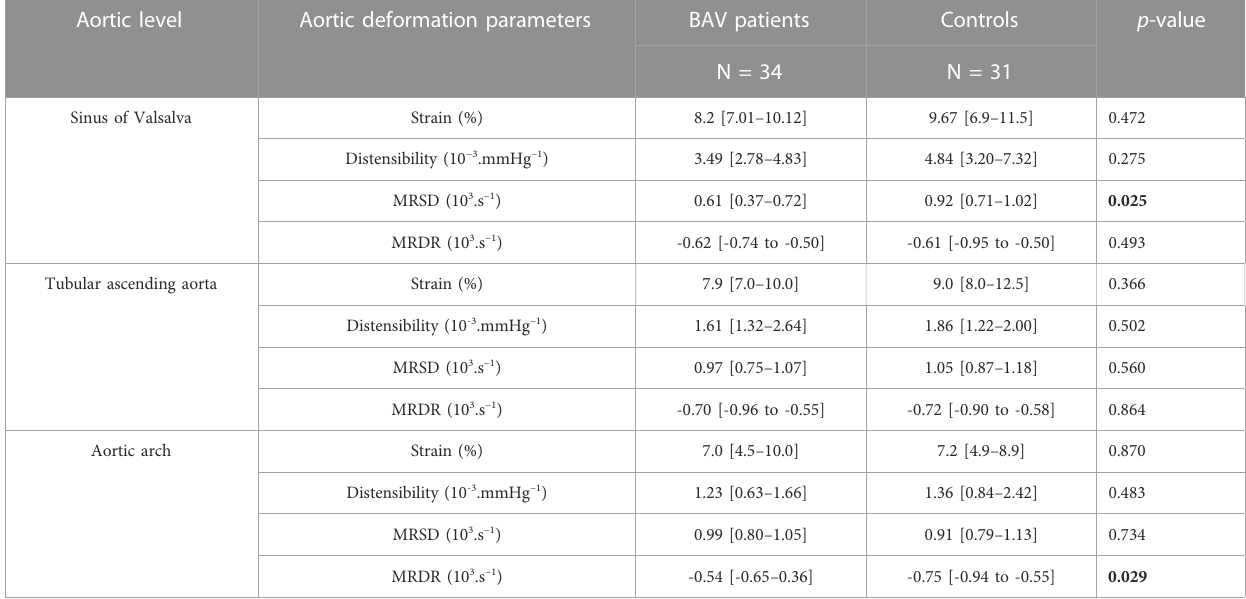
TABLE 2 Aortic parameters obtained by ultrafast ultrasound imaging for BAV patients and controls. Comparisons are made using a Mann-Whitney test. BAV: bicuspid aortic valve; MRSD: maximal rate of systolic distension. A Mann-Whitney test obtains the p -values. Data in bold correspond to statistically signi fi cant comparisons ( P <